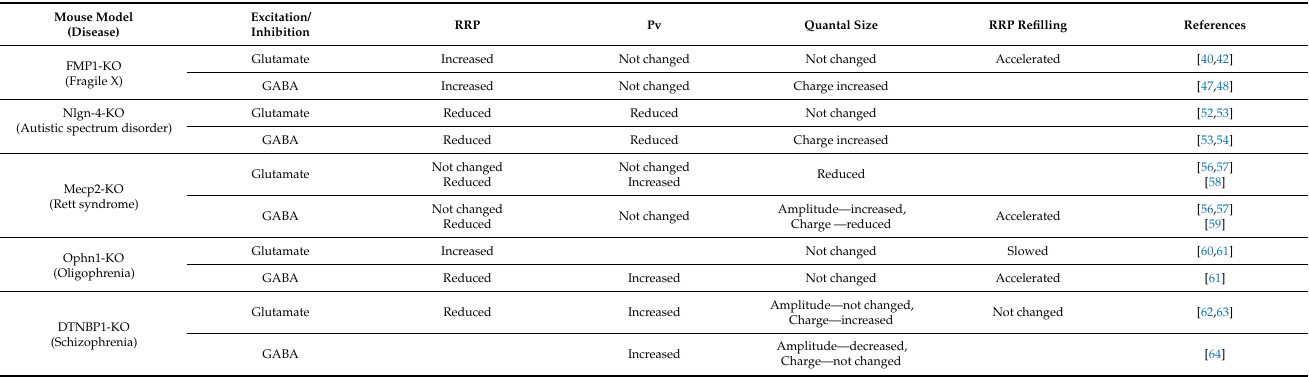
Table 1. Changes in glutamatergic and GABAergic transmission observed in the mouse models. Empty boxes mean “no data reported”. Note that both mean amplitude and area of mPSCs (if reported) are mentioned in the column “Quantal